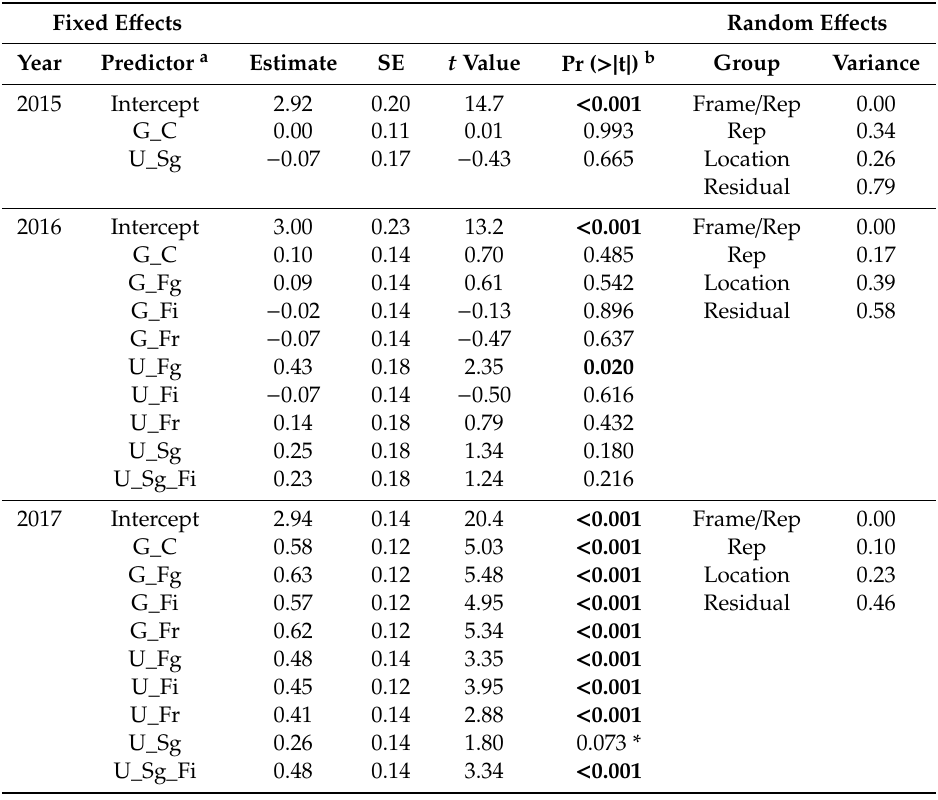
Table 5. The response of total plant cover to grazing and / or herbicide treatments, analyzed using a linear mixed e ff ects model. All treatments (parameters) are with respect to the ungrazed control treatment (U_C), which is the intercept in the model. In 2015 only the grazed (G) and ungrazed control, and the spring applied herbicide treatment results are shown, because fall herbicide application had not yet occurred. Results are based on log transformed total plant